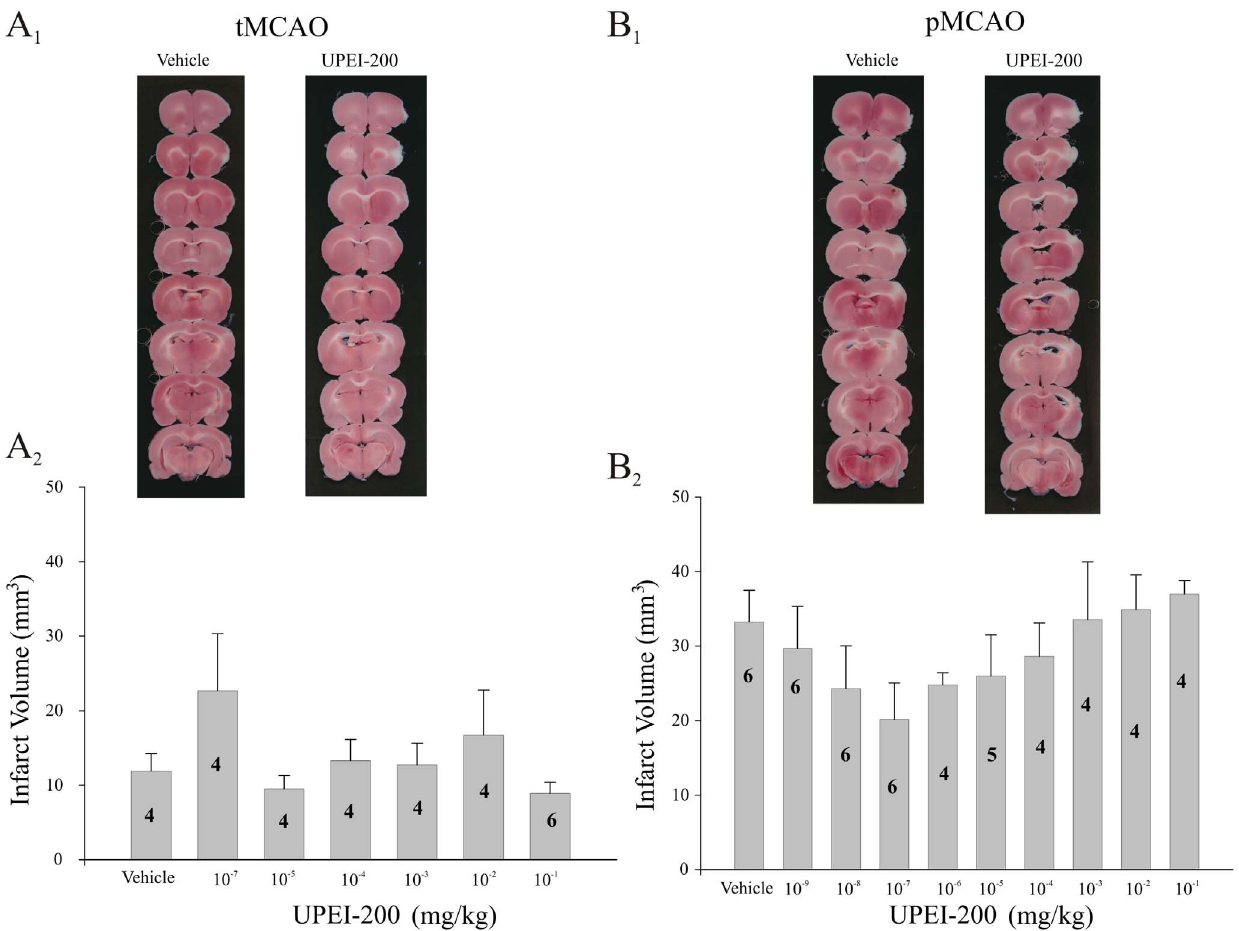
Figure 6. Lack of an effect of UPEI-200 on ischemic or reperfusion injury-induced cell death. (A 1 ) Representative photomicrographs of TTC-stained sections from vehicle and UPEI-200-treated animals prior to either ischemia/reperfusion (tMCAO; A 1 ) or permanent middle cerebral artery occlusion (6 hr pMCAO; B 1 ). Bar graphs illustrating the lack of effect on infarct volume of UPEI-200 (3:1 ratio of lipoic acid to resveratrol) at increasing doses or a vehicle (propylene glycol 4 6 10 2 3% (v/v)) injected 30 minutes prior to either tMCAO (A 2 ) or pMCAO (B 2 ). Each bar represents the mean 6 S.E.M. (n=4–6/group).